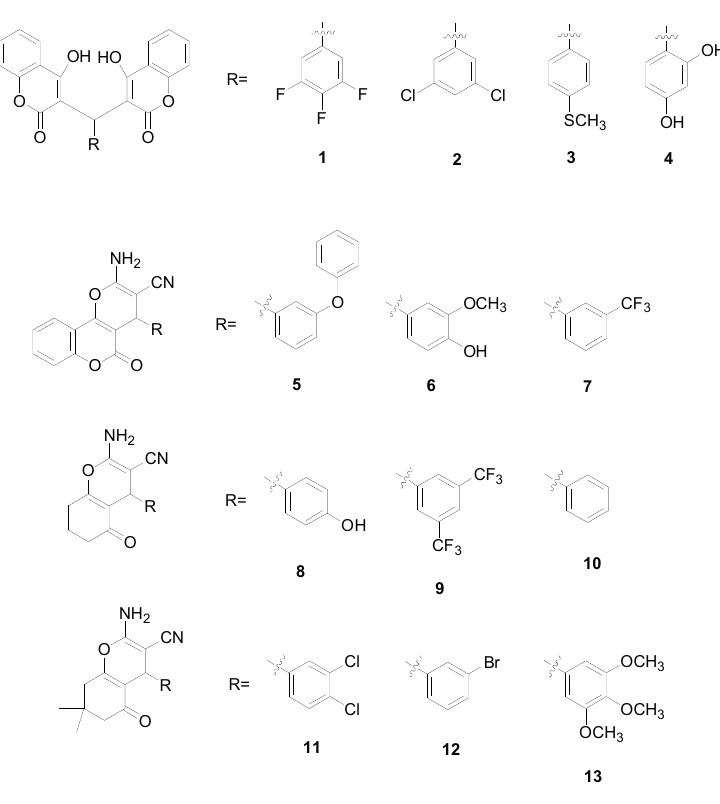
Figure 1. Chemical structures of compounds 1 – 13